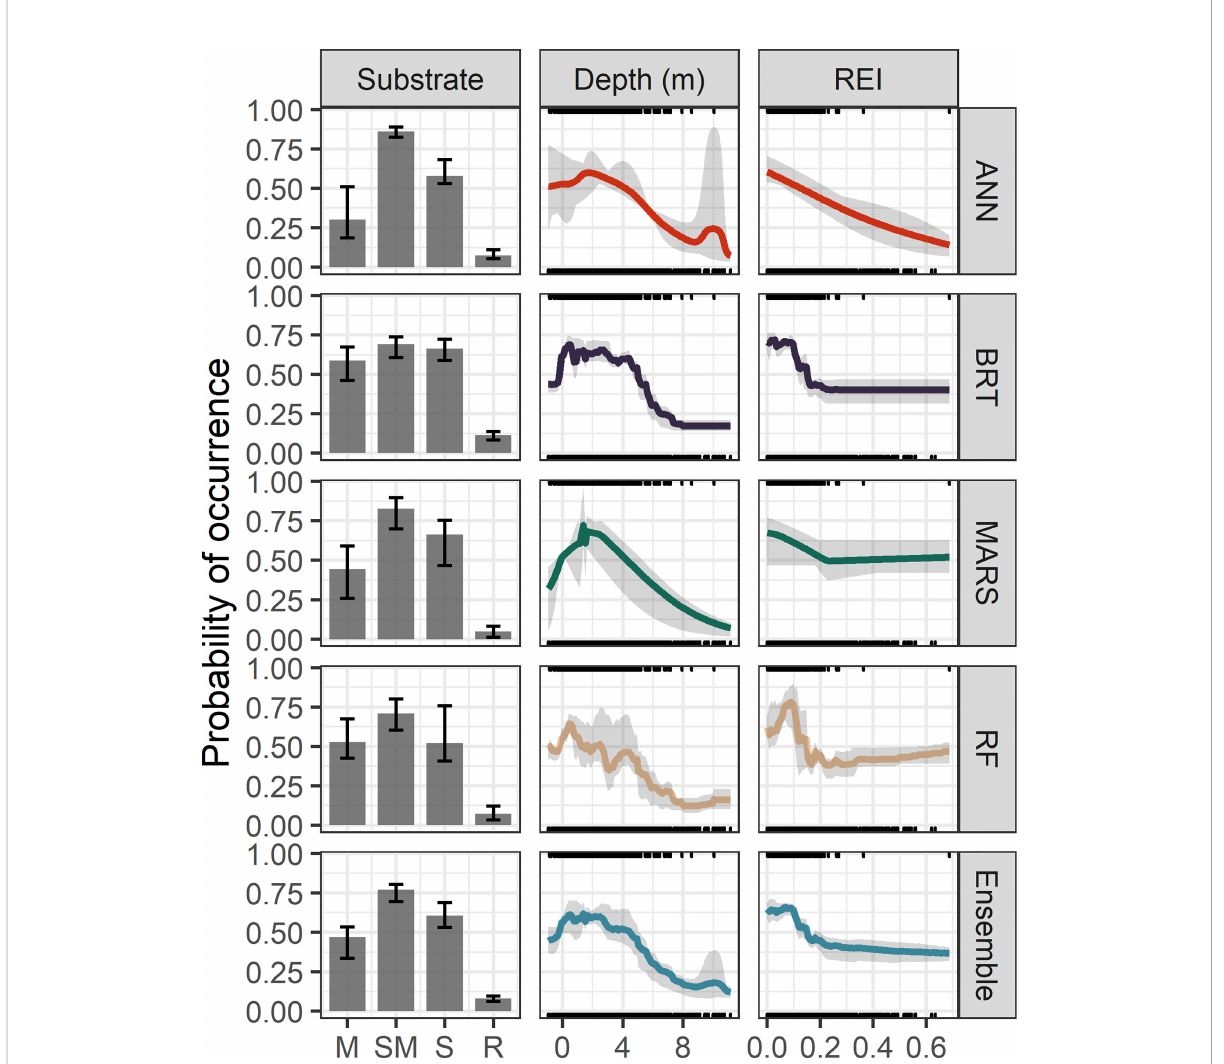
FIGURE 7 Response plots for the 3 most in fl uential predictors of eelgrass occurrence in the top-performing individual species distribution modeling methods (MARS, BRT, ANN, RF) and the ensemble model. Predictors include categorical substrate type (muddy – M, sand & mud – SM, sandy – S, rocky – R), depth (m), and a relative exposure index to wind-driven waves (REI, unitless). Bars and lines show the mean probability of occurrence predicted by each model method over 5 cross-validation runs across the range of each predictor with other variables held at their median value. Error bars and shaded regions indicate the maximum and minimum value across the 5 CV runs. Rug plots show the marginal distributions of predictors in the calibration data for records of eelgrass presence (top) and absence